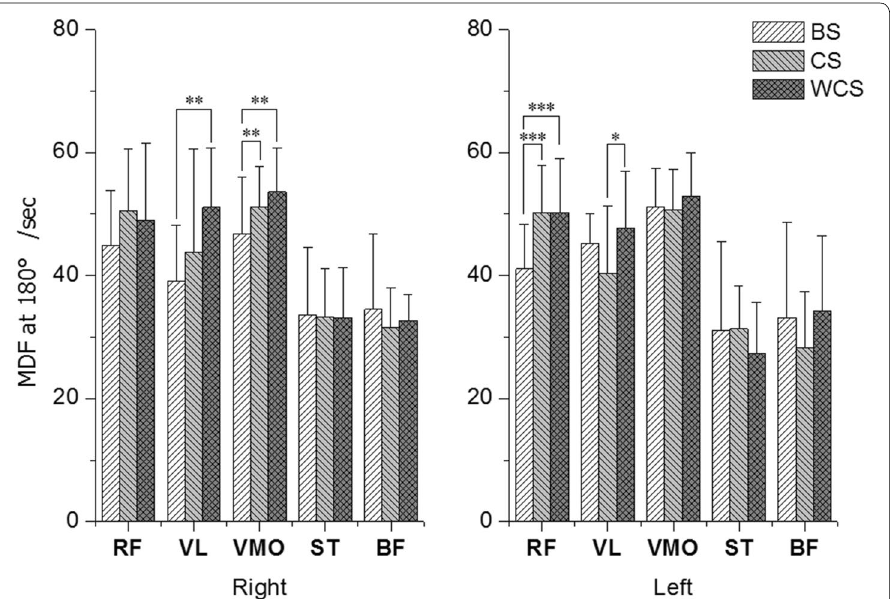
Fig. 10 MDF at the angular velocity of 180°/s: left is for the data of left leg; right is for the right leg